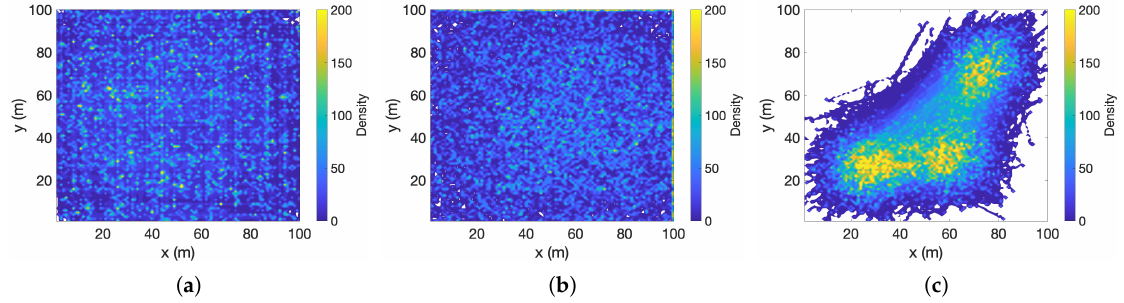
Figure 4. Density for m 2 of the synthetic scenarios. ( a ) Random WayPoint Model (RWP); ( b ) SWIM: ( c ) RWPa.